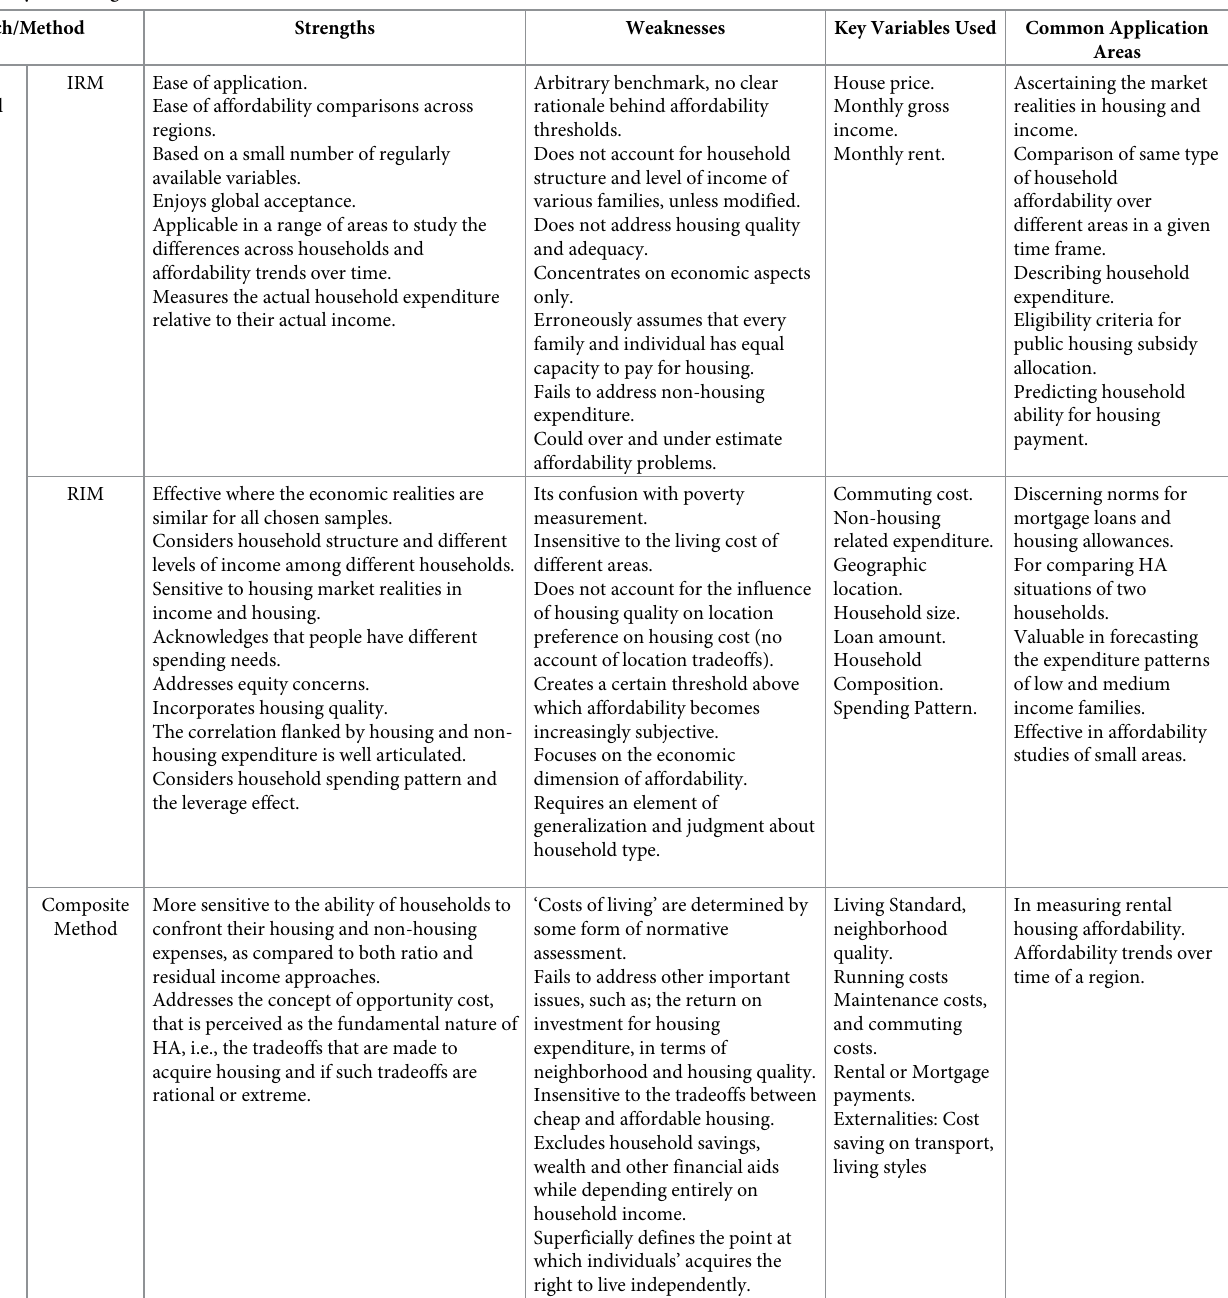
Table 3. Summary of findings based on the literature